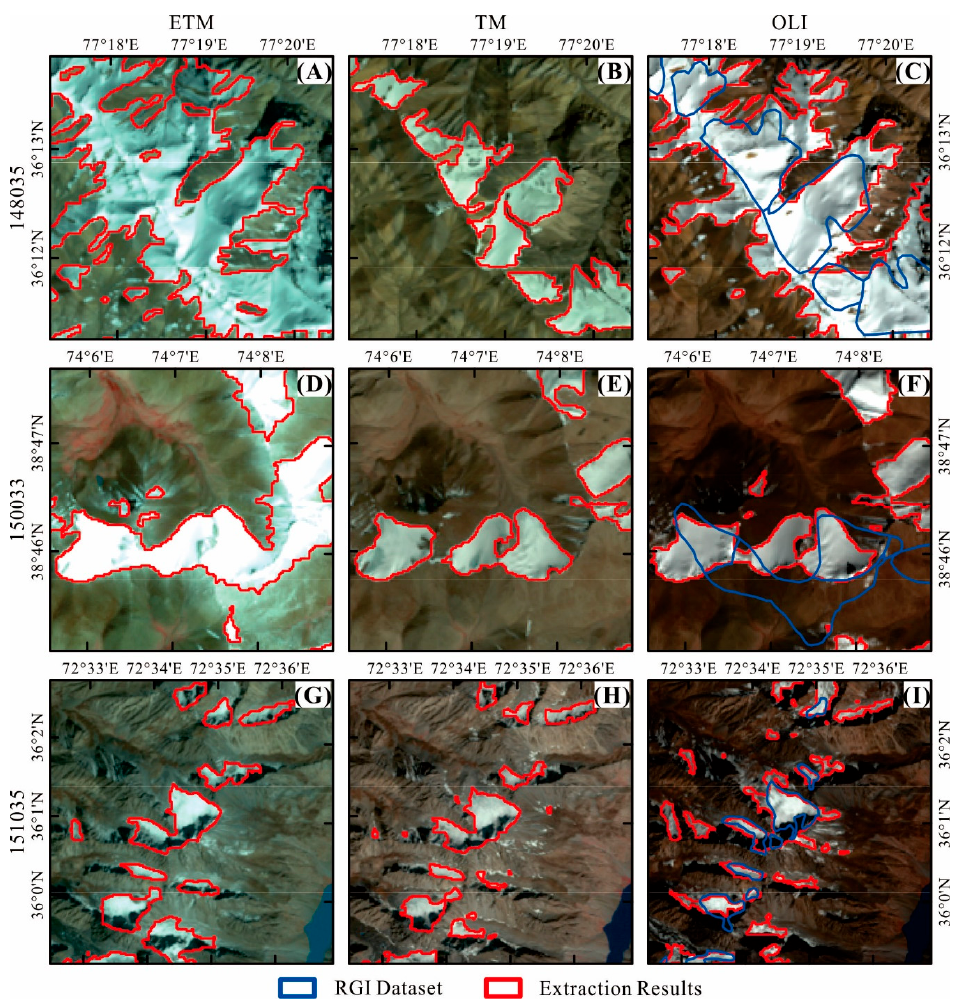
Figure 6. The delineated ice/snow boundaries based on the proposed method. ( A ) Image A; ( B ) Image B; ( C ) Image C; ( D ) Image D; ( E ) Image E; ( F ) Image F; ( G ) Image G; ( H ) Image H; and ( I ) Image I.